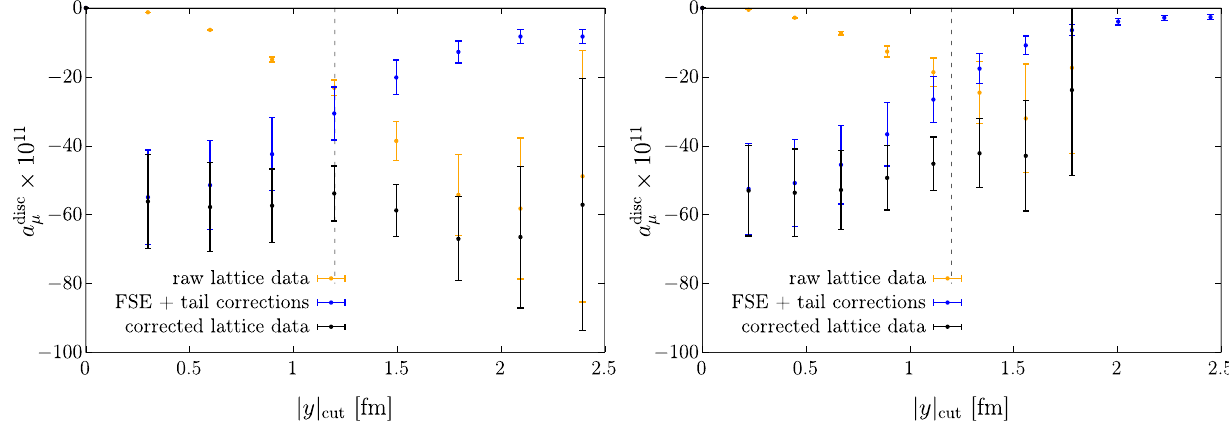
Fig. 13 Value of a disc μ as a function of | y | cut for ensembles H101 (left) and N202